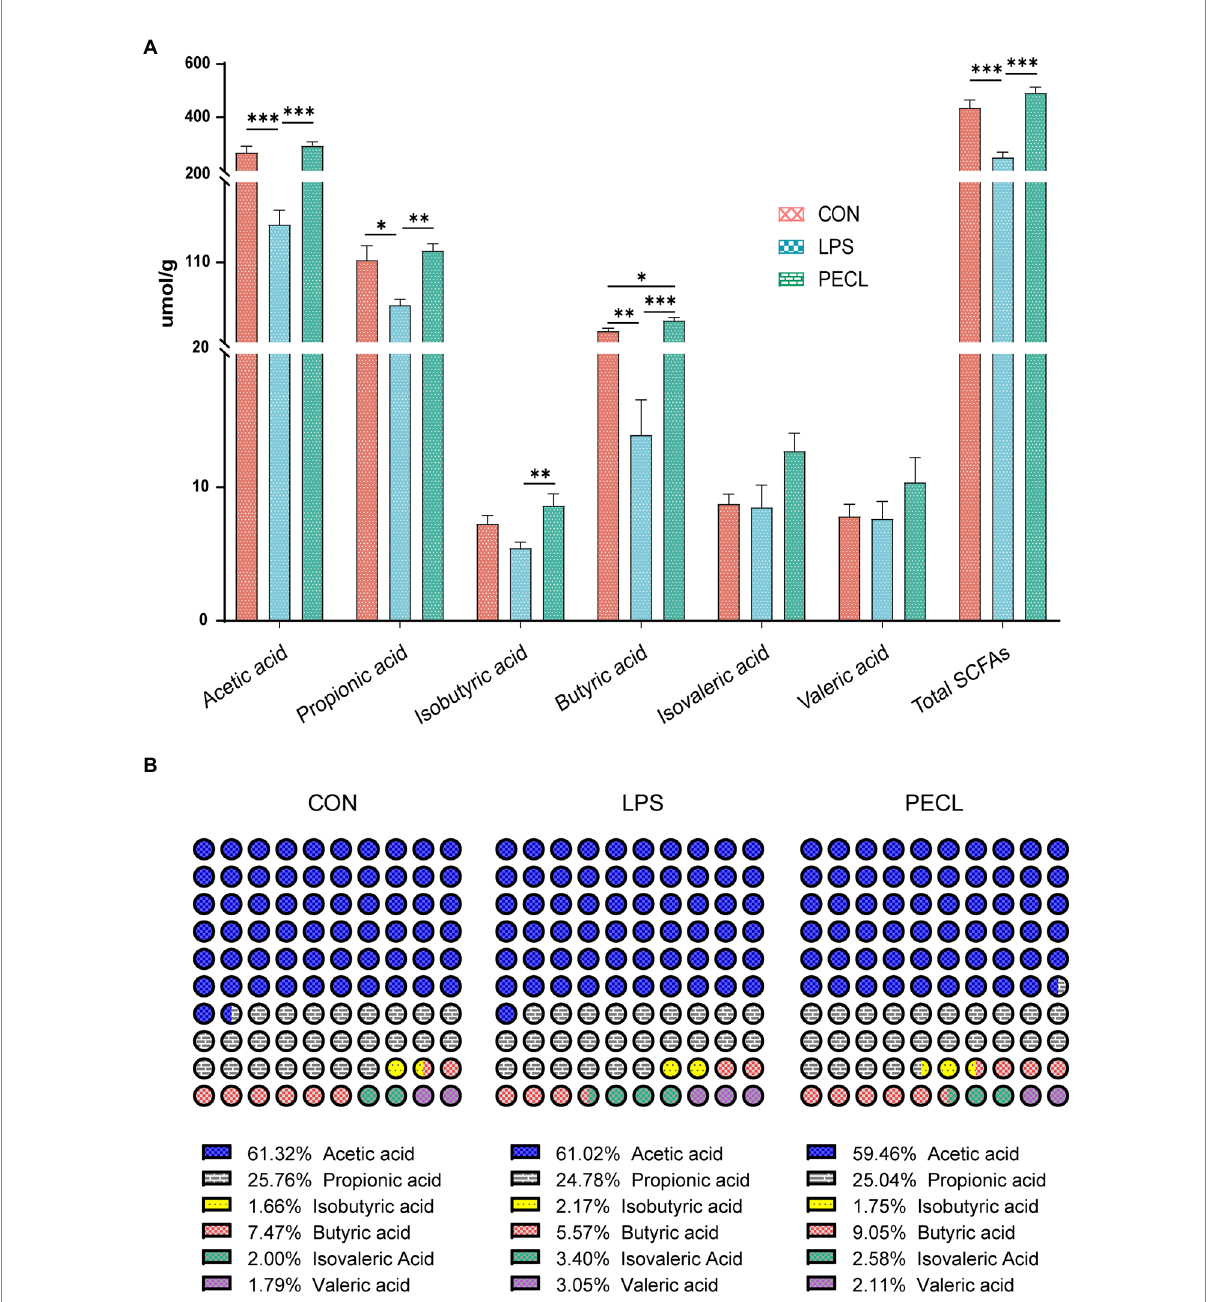
FIGURE 7 Effects of Pectin on SCFA concentrations (A) and compositional proportion (B) in the cecum of pigs. Signification is presented as * p < 0.05, ** p < 0.01, and *** p < 0.001; data are presented as the mean ±